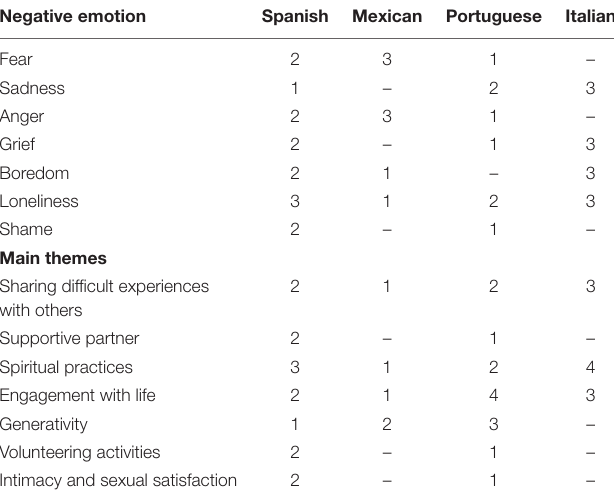
TABLE 2 | Distribution by countries of negative emotions and main themes